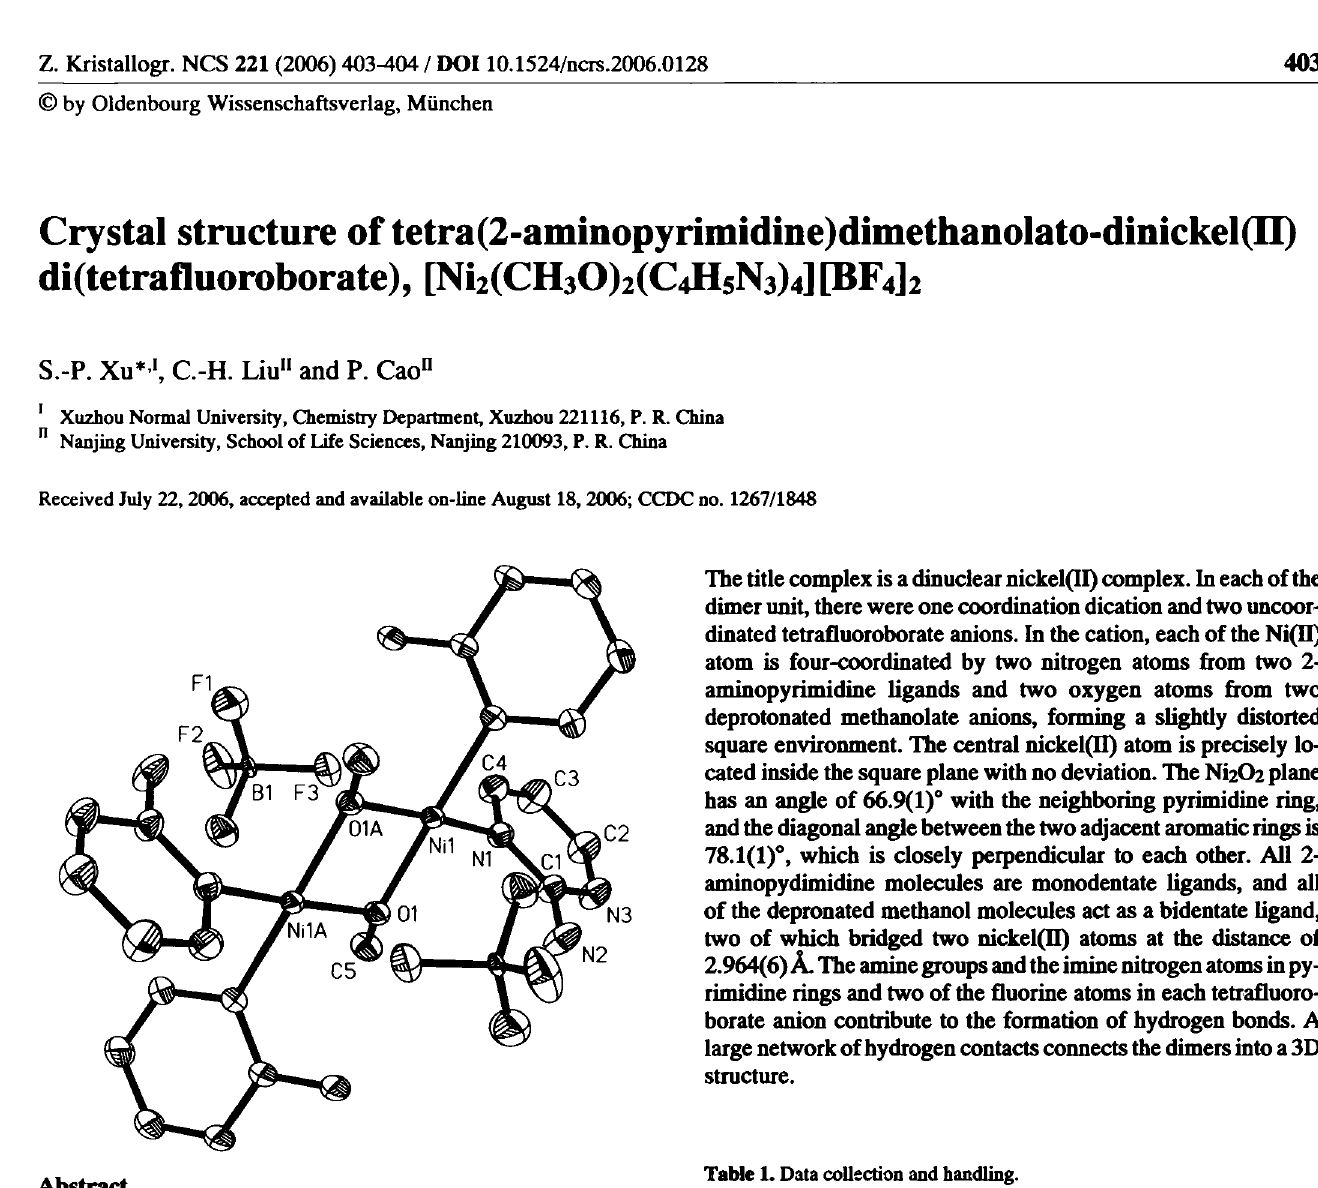
Table 2. Atomic coordinates and displacement parameters (in Ä 2